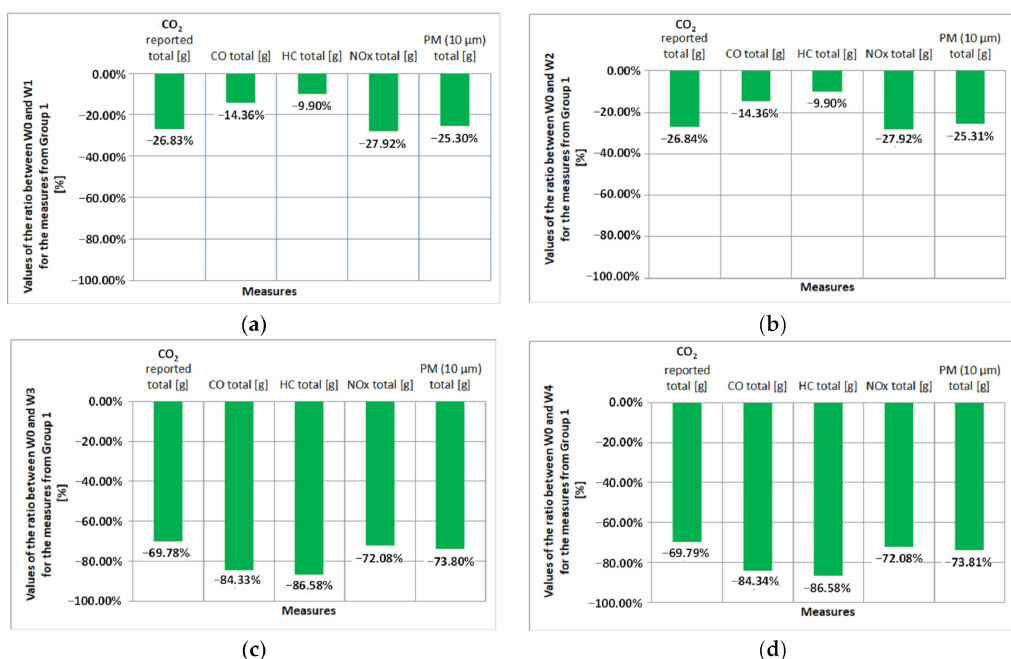
Figure 21. Values of the ratio between W0 and individual scenarios W1–W4 for the measures from Group 1—analysis for the whole city: ( a ) the ratio between scenario W0 and W1; ( b ) the ratio between scenario W0 and W2; ( c ) the ratio between scenario W0 and W3; ( d ) the ratio between scenario W0 and W4.